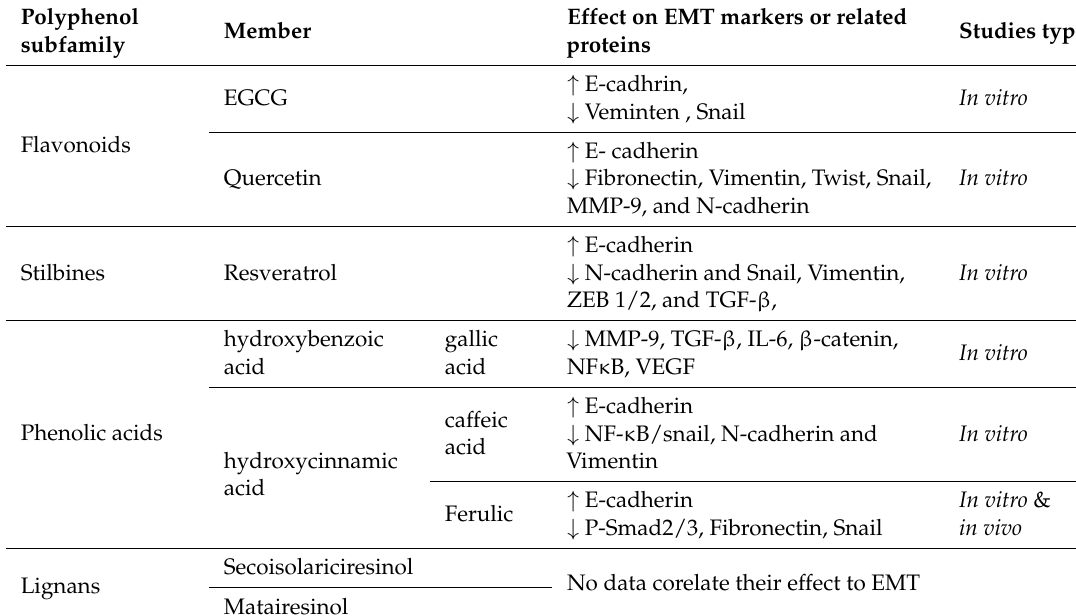
Table 1. A summary of the effect of selected polyphenolic compounds on the EMT markers and proteins in the related